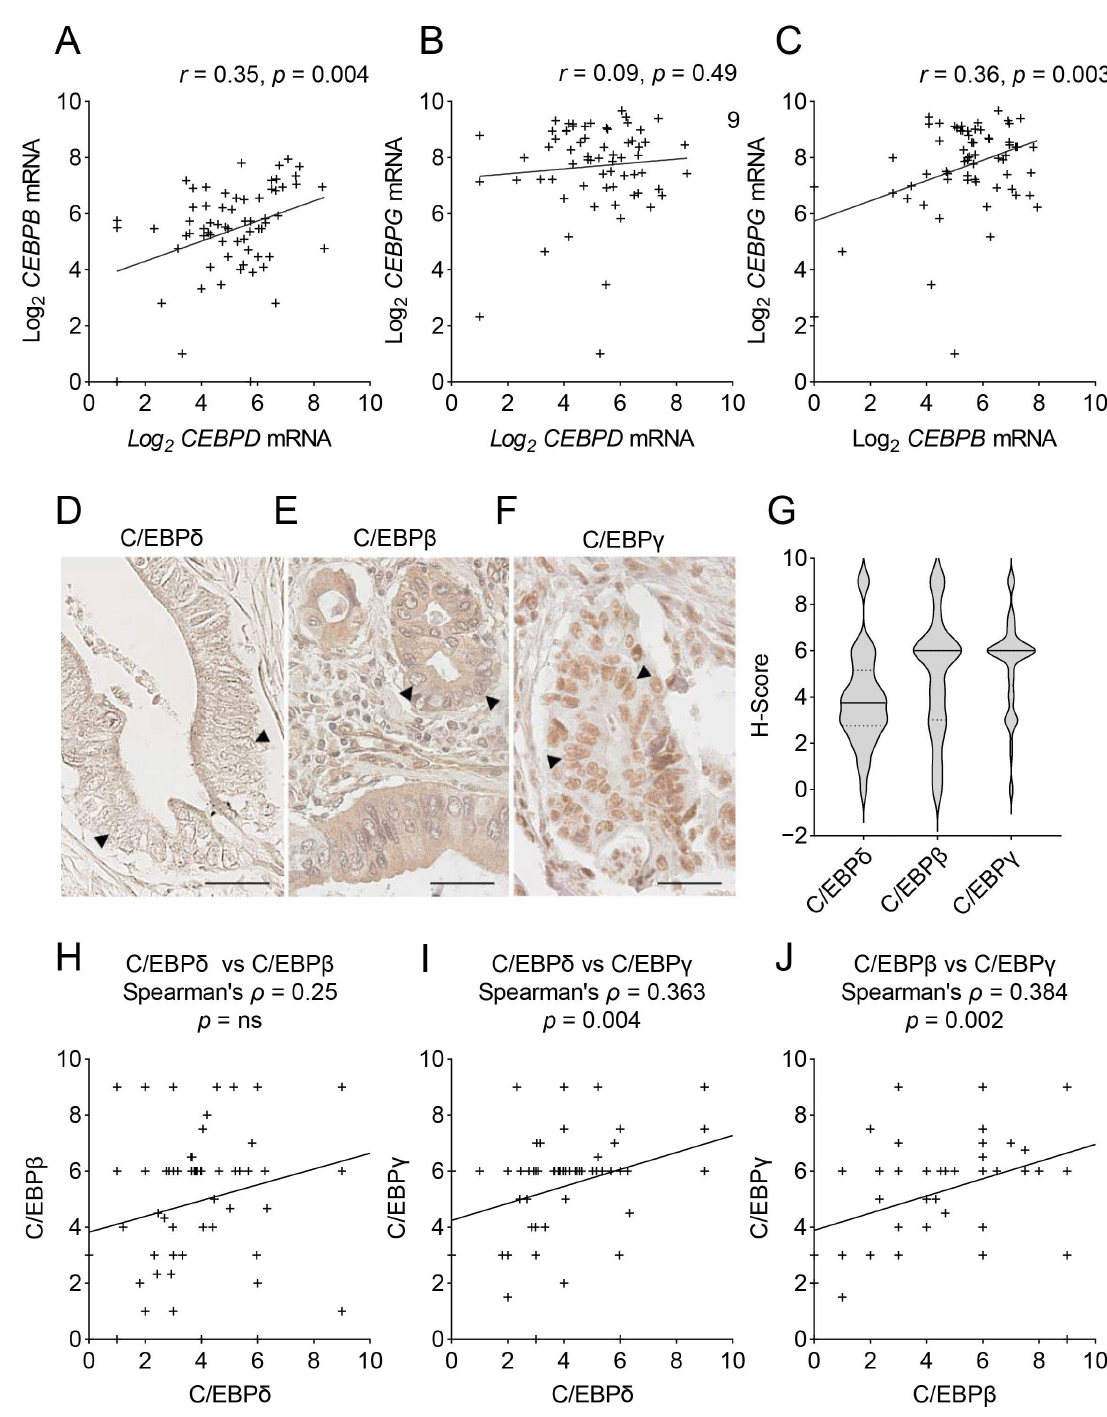
Figure 2. Correlations of CEBPD , CEBPB and CEBPG mRNA and protein expression in PDAC. ( A – C ) Shown are XY-plots of the correlations of ( A ) CEBPD vs. CEBPB mRNA, ( B ) CEBPD vs. CEBPG mRNA and ( C ) CEBPB vs. CEBPG mRNA in the publicly available mRNA-sequencing dataset pub- lished by Renz et al. [24]. Denoted are the Pearson correlation coefficient ( r ) and the significance ( p ) of the correlation. ( D – F ) Immunohistochemical staining of C/EBP δ ( D ), C/EBP β ( E ) and C/EBP γ ( F ) in PDAC tissues. Arrow heads mark tumor cell nuclei. Scale bars = 40 µm. ( G ) Shown are the distri- butions of H-scores for C/EBP δ , C/EBP β and C/EBP γ in 68 PDAC cases. Dotted lines mark the upper and lower quartiles, full line marks the median. ( H – J ) XY-plots show the correlation of H-scores (as shown in Figure 3D) for all three proteins against one another. Denoted are Spearman’s correlation coefficient ( ρ ) and the significance of the correlation ( p ). ’+’ signs mark individual patients in XY- plots, ‘++’ indicates two patients with similar expressions. ns = not significant.